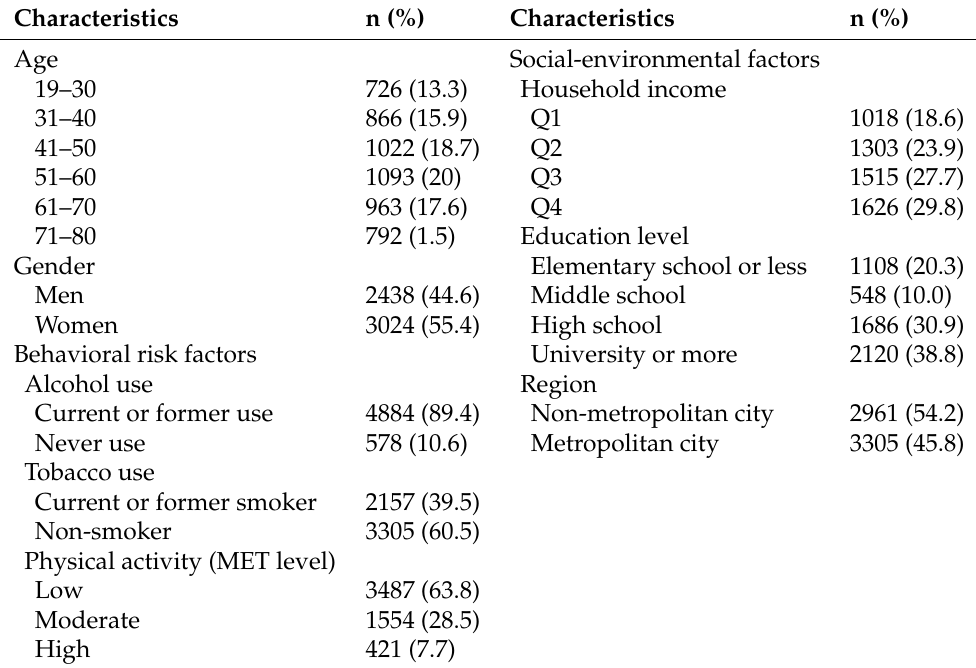
Table 1. Characteristics of the